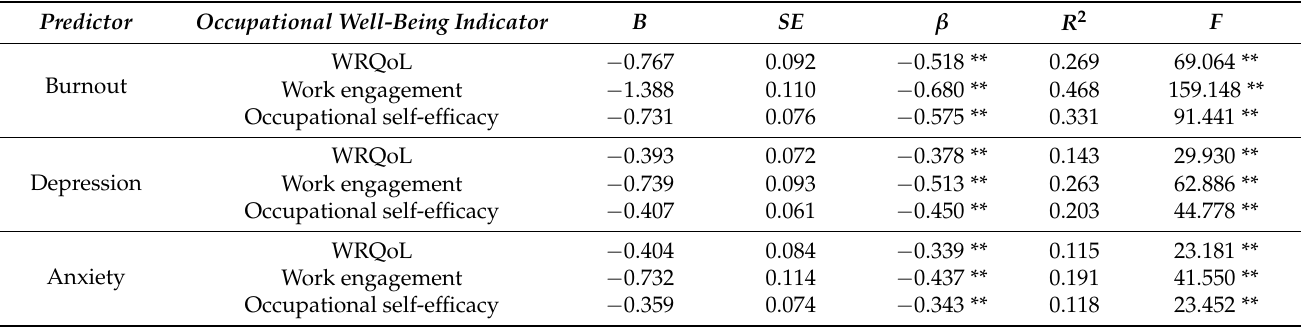
Table 4. Simple logistic regressions for psychological distress variables predicting occupational well-being